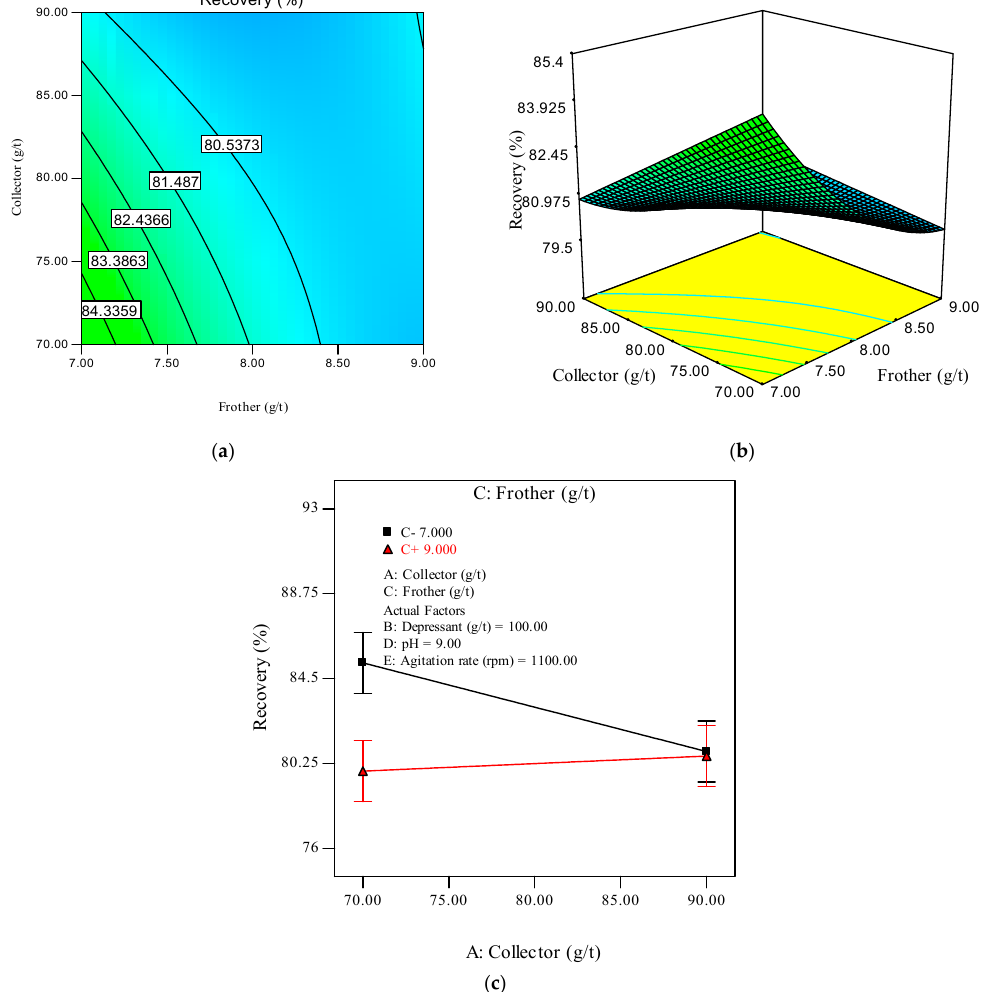
Figure 3. ( a ) Contour and ( b ) 3D response surface plots showing the combined effect of collector and frother and ( c ) their interaction effect on the copper recovery.